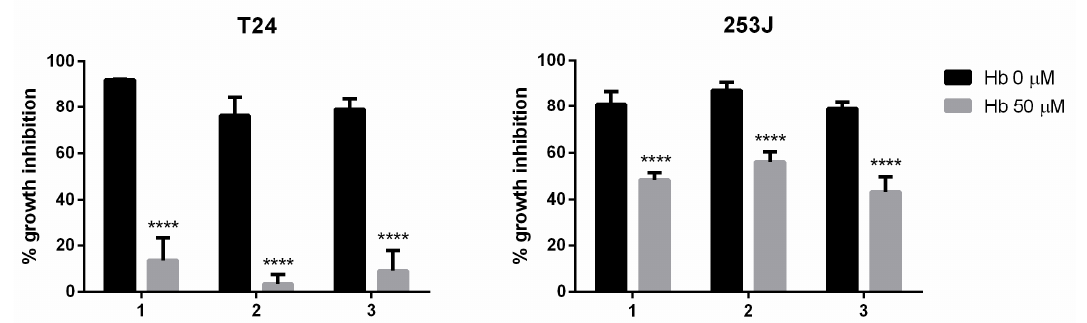
Figure 4. Effects of hemoglobin (Hb) on the antiproliferative effect of · NO-donor compounds. The results are expressed as the percentage of cell growth inhibition relative to the control cells. The data are the means ± standard deviation obtained from three determinations. Statistical analysis: a two-way ANOVA followed by a Bonferroni multiple comparison test: **** p < 0.0001.